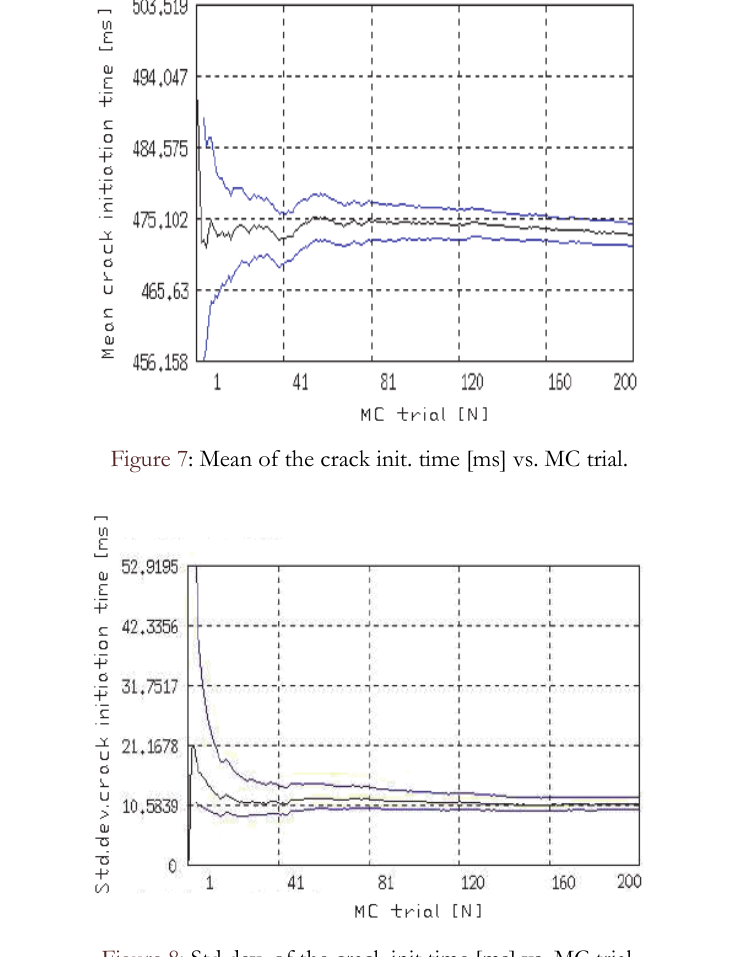
Figure 8: Std dev. of the crack init time [ms] vs. MC trial.